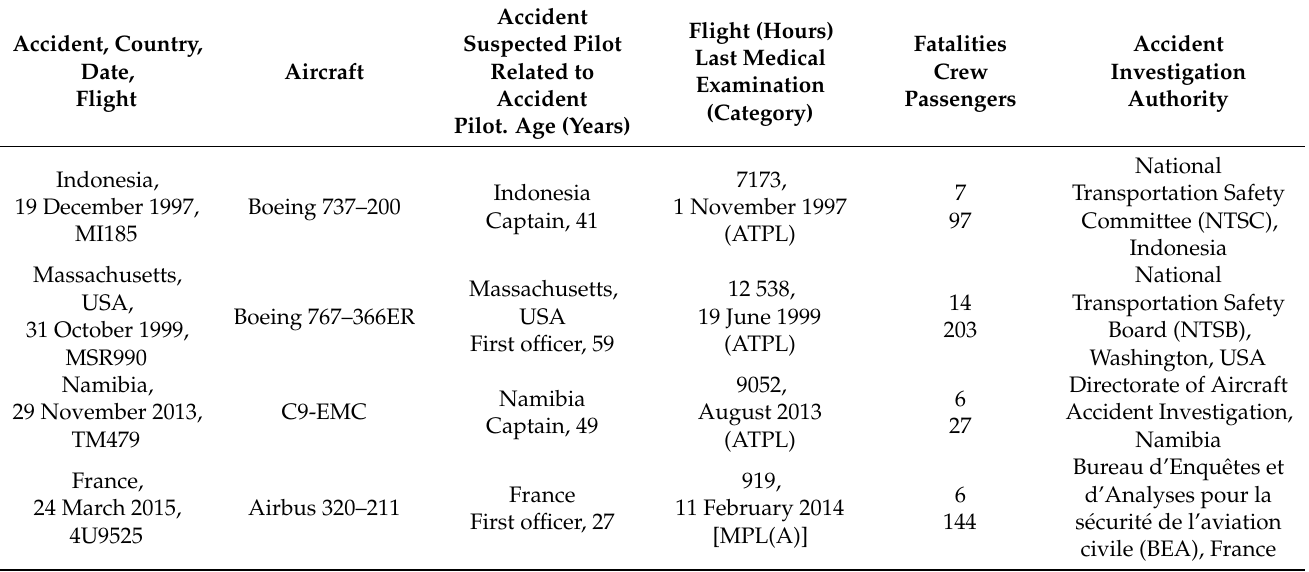
Table 1. Analyzed accidents [10–13].